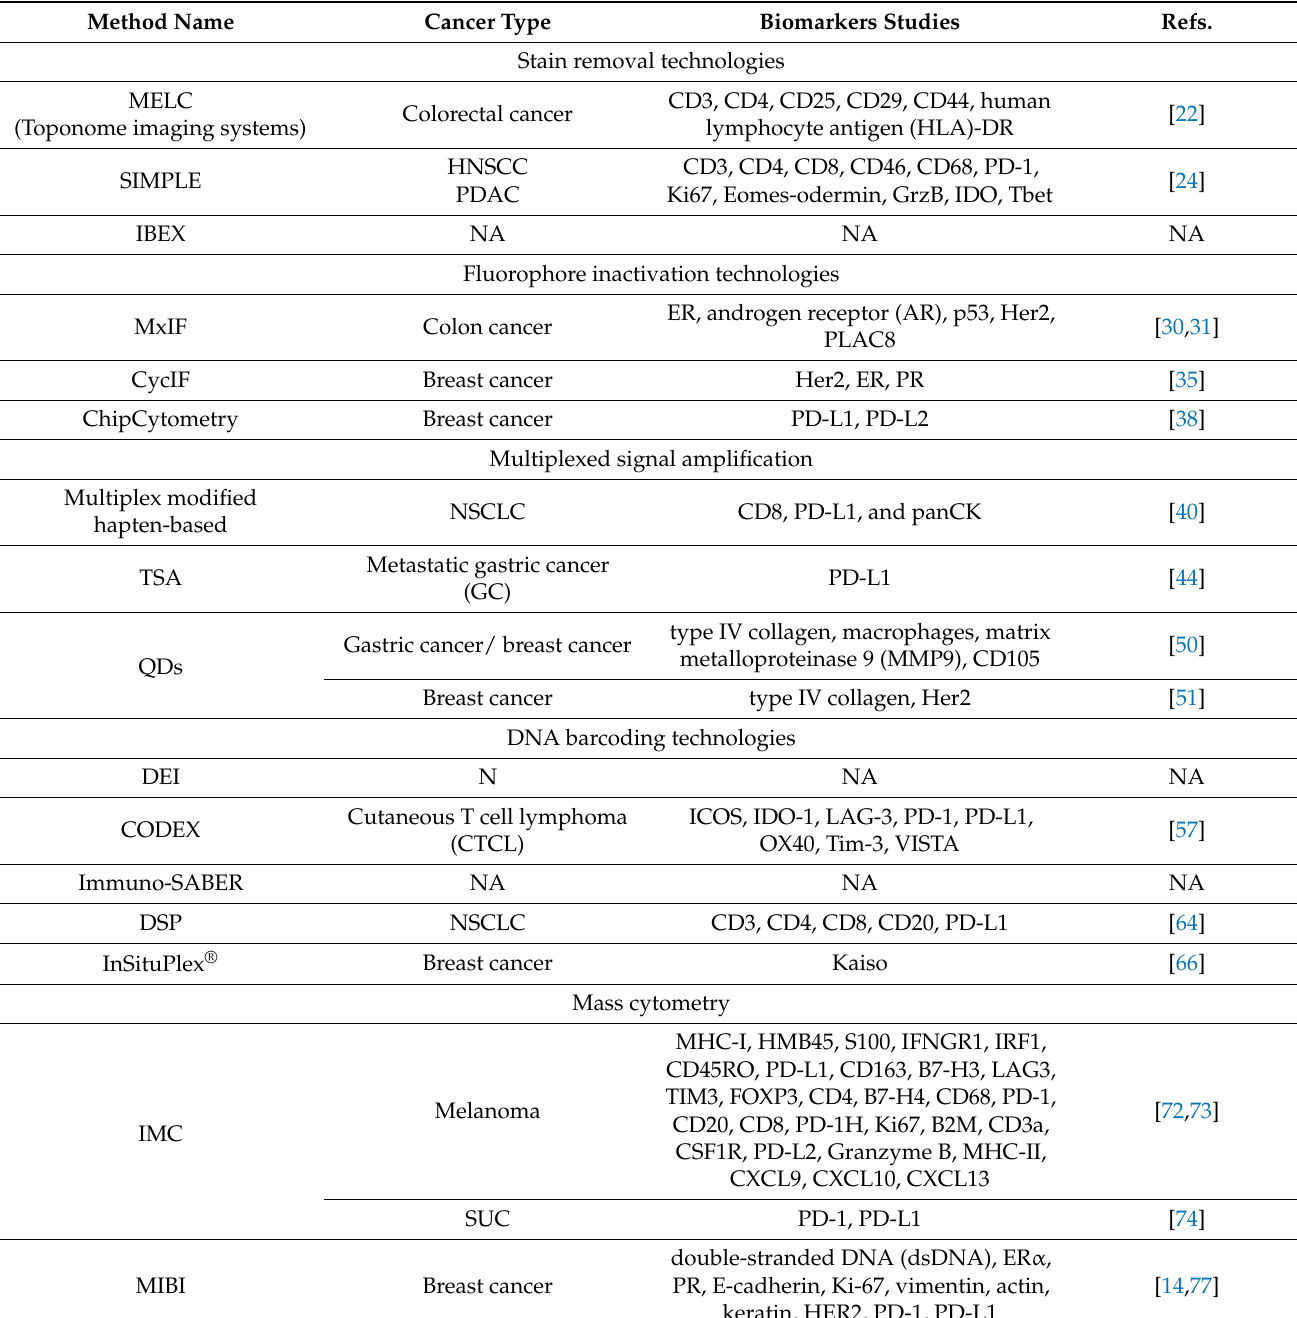
Table 2. Applications of mfIHC technologies clinical